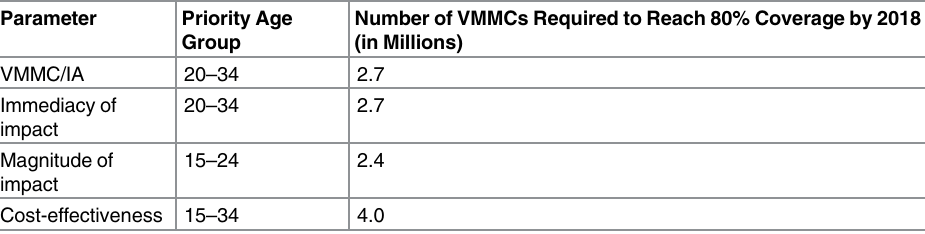
Table 2. Priority Age Groups for Each Model Parameter within the Analytical Framework.